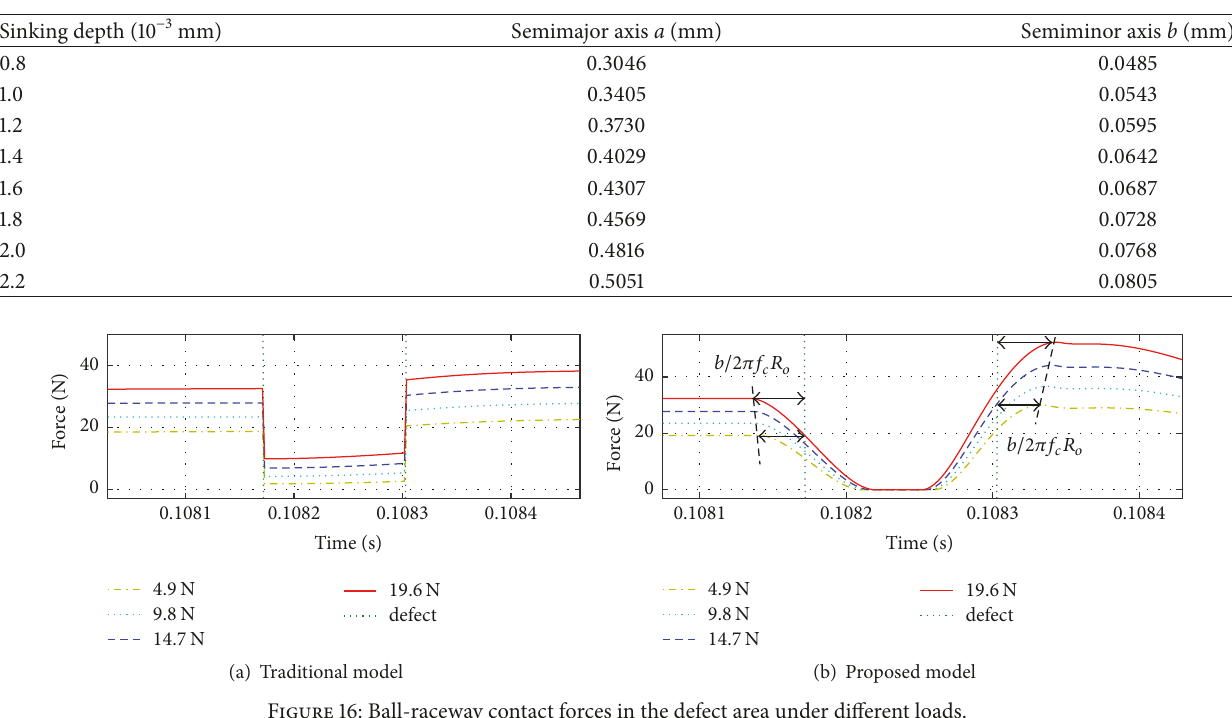
Table 4: Relationships of Δ - 𝑎 - 𝑏 .